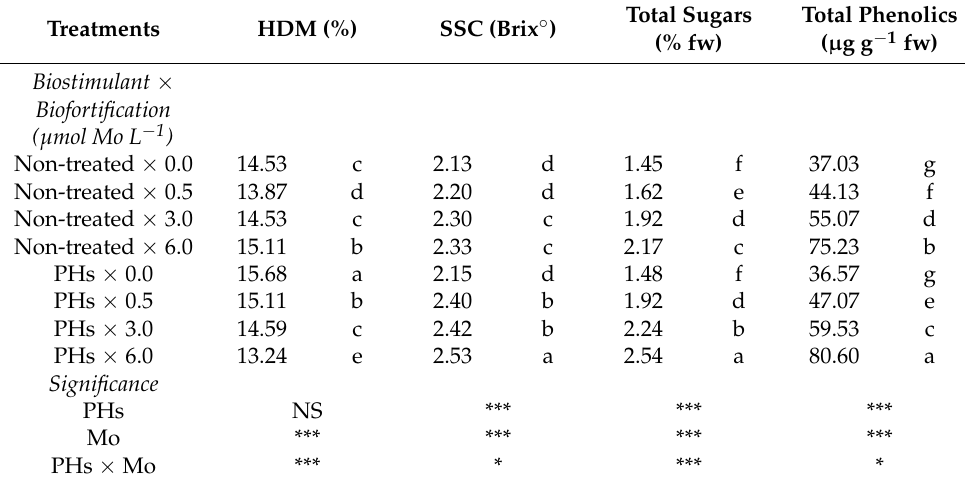
Total Sugars Total Phenolics (% fw) ( µ g g − 1 fw)